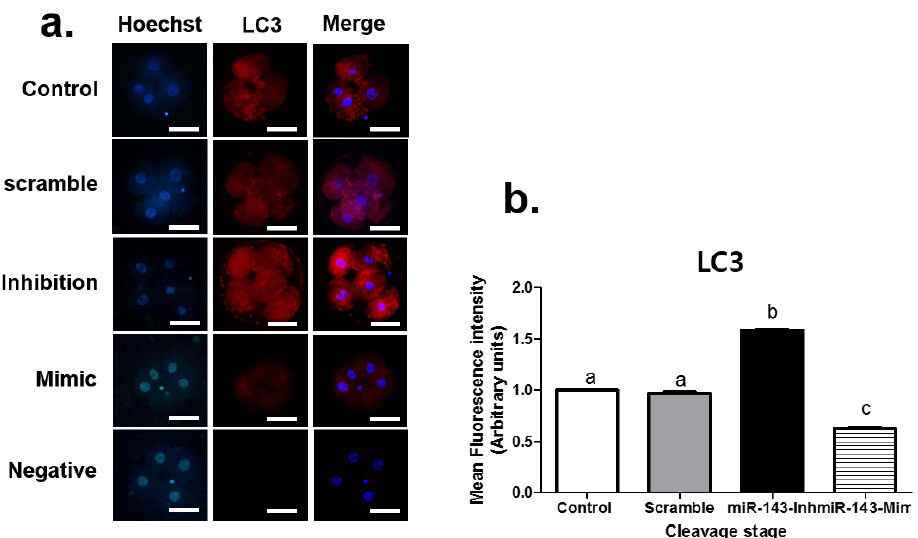
Figure 1. Expression of LC3 immunostaining in cleavage stage embryos on Day 2 after microinjection with miR-143. ( a ) Representative fluorescence images of LC3 expression and Hoechst staining. In addition, merge is the combination figure of Hoechst and LC3 staining. ( b ) Graph showing quantitation of LC3 fluorescence intensity. Data are presented as standard error of the mean (±SEM), with each experiment performed using at least 24 embryos per group, obtained from four biological replicates. Groups labeled with different lowercase letters indicate statistically significant differences ( p < 0.05). Scale bars = 50 μm, magnification = 400×. miR-143-Inh = microRNA 143-Inhibitor, miR-143-Mim = microRNA 143-Mimic.